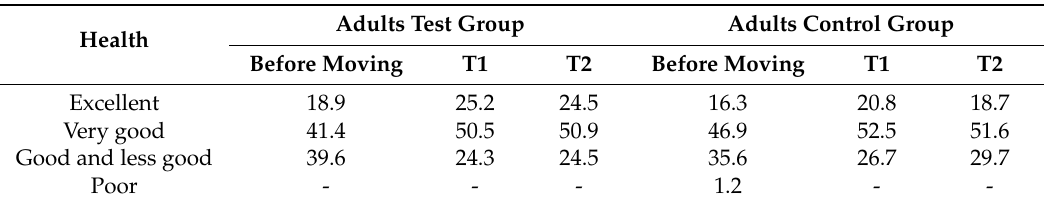
Table 2. Parental rating of their children’s health (percentages) at T1 (three months after moving in) and at T2 (one year later). Children Test Group Children Control Group Health T1 T2 T1 T2 Excellent 60.5 41.5 28.2 50.0 Very good 21.1 43.9 53.9 41.2 Good and less good 18.4 14.6 17.9